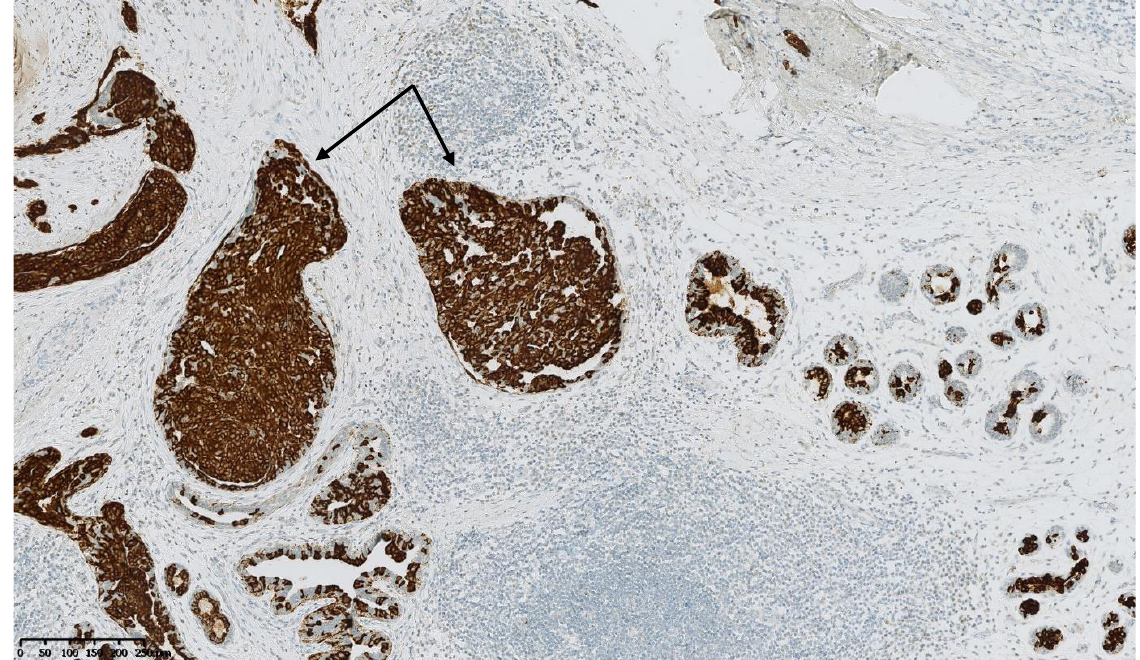
Figure 6. Estrogen receptors immunostaining: the hyperplastic ducts (arrows) show a heterogeneous expression of estrogen receptors, as do the normal ducts and lobules in the vicinity.